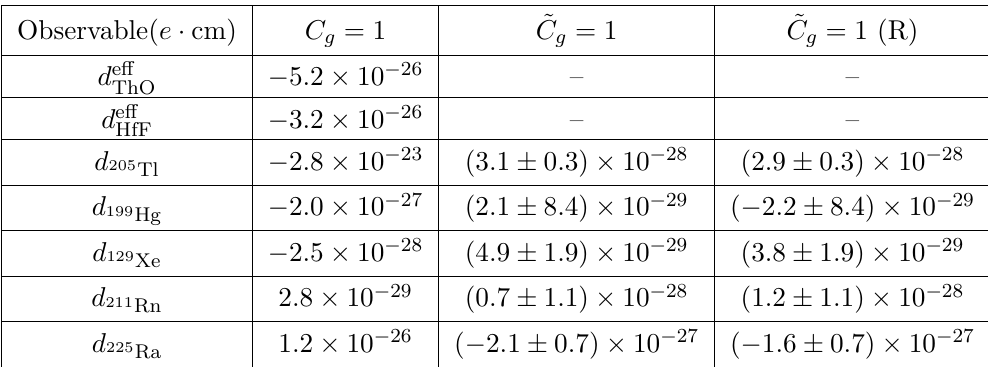
Table 2 . Contributions to observable EDMs in benchmark scenarios described in the text. Note: contribution to direct electron EDM is not included. The results in the column marked with (R) are computed with QCD running and matching e(cid:11)ects which are not taken into account in the remaining columns. For ~ C g = 1 scenario, the indicated uncertainties are conservative estimates based on the estimation of uncertainties of nucleon matrix elements given in appendix A.